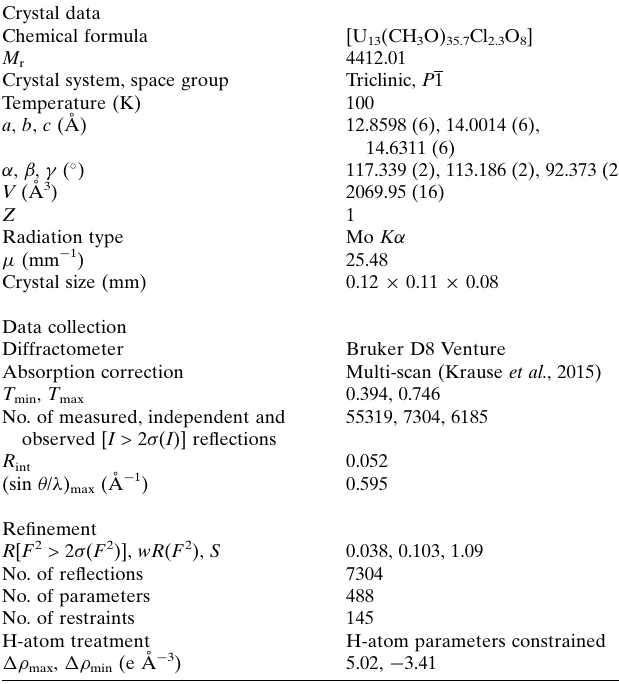
Table 3 Experimental details. Crystal data Chemical